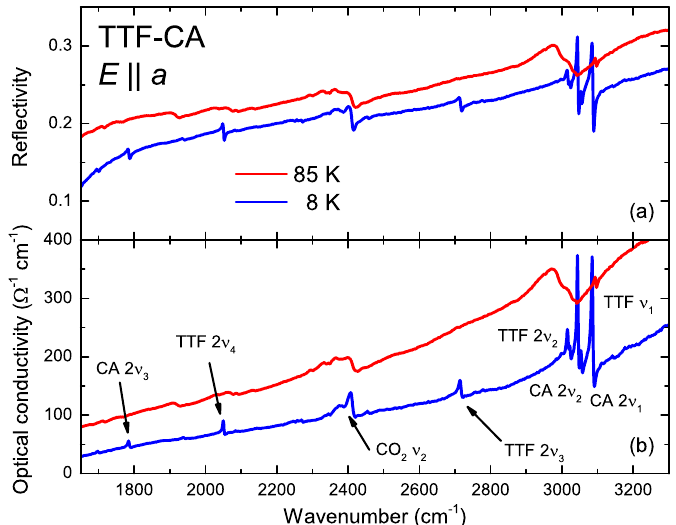
Figure 19. ( a ) Optical reflectivity of TTF-CA for T = 8 K (blue) and 85 K (red) measured along the a -direction; ( b ) Corresponding conductivity as a function of frequency for the same temperatures. The peaks at 3200 cm − 1 originate from the C–H vibration of the TTF molecule. The weak resonances mainly belong to higher harmonic vibrations of both molecules, CA and